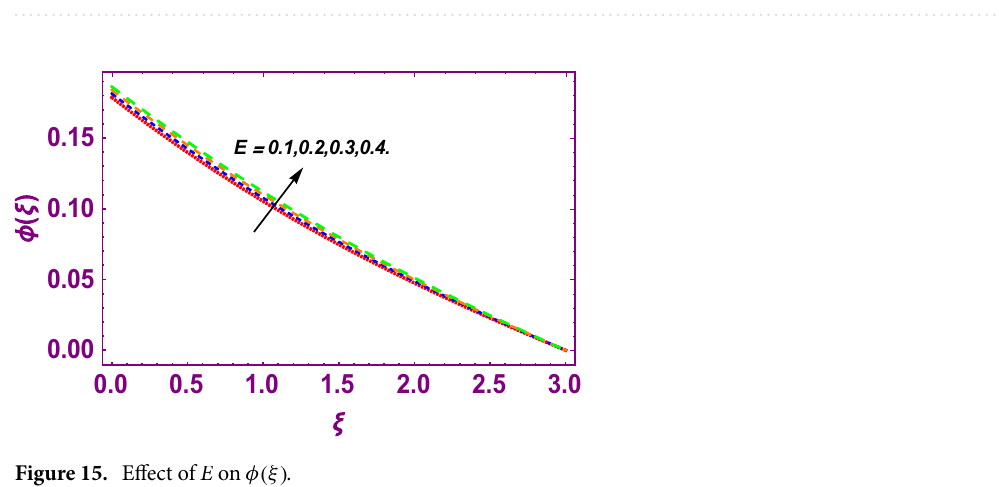
Figure 15. Effect of E on φ(ξ)